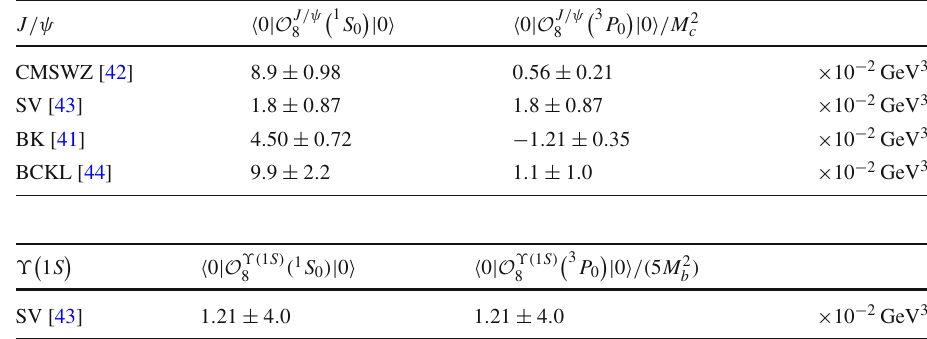
= 4 GeV − 2 ( J /ψ production) and C 2 = 1 GeV − 2 T T